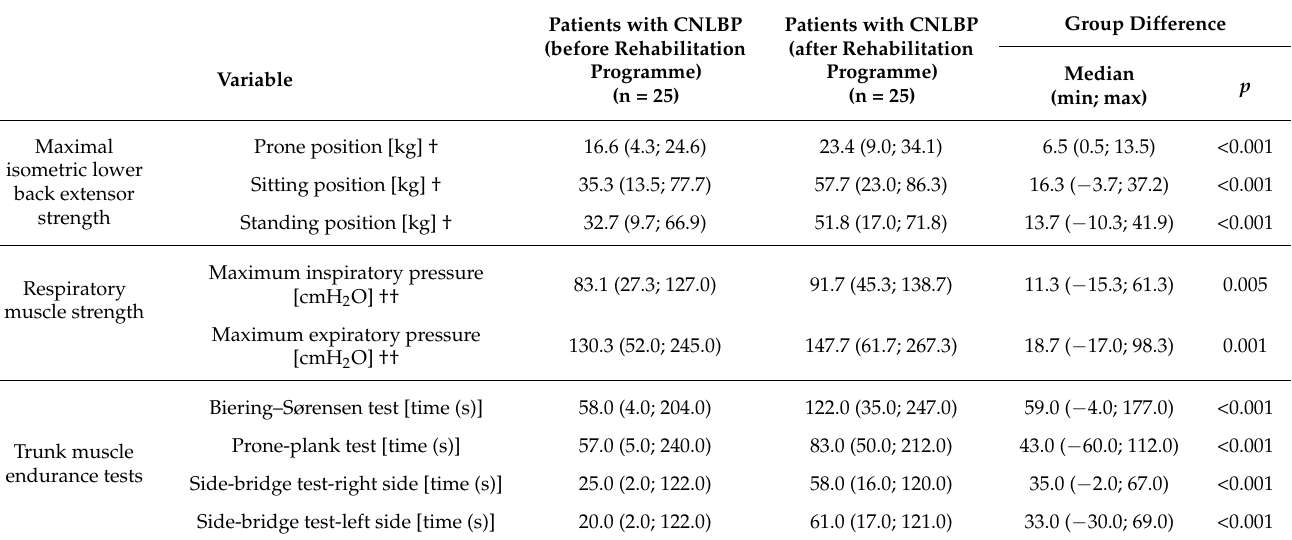
Table 6. Functional parameters of trunk muscles—Before and after rehabilitation